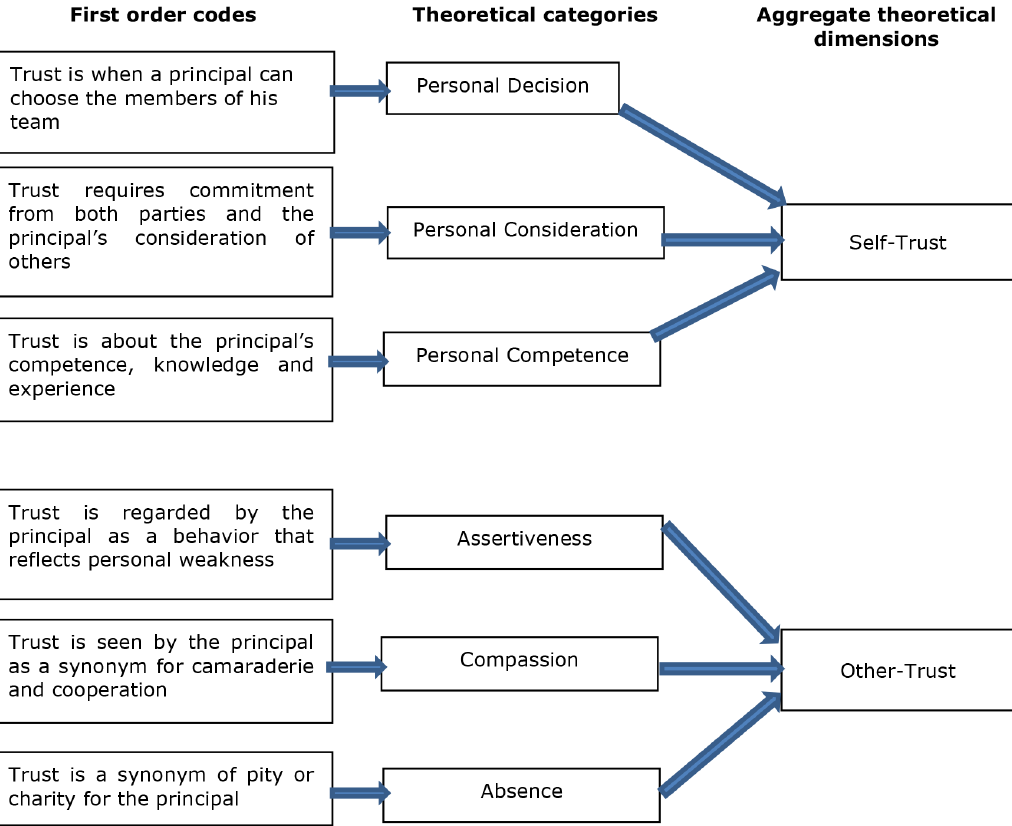
Figure 1. First order codes, theoretical categories and aggregate theoretical